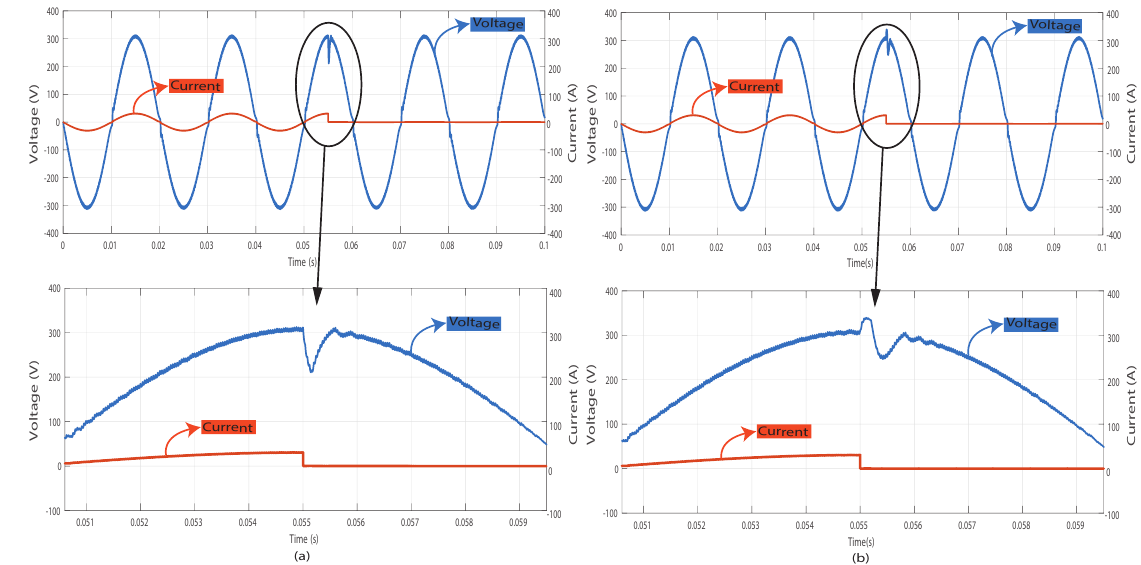
Figure 5. Simulation results of the PWM-based hysteresis SM controller. ( a ) Transient response of the system when additional load is connected. ( b ) Transient response of the system when additional load is removed.